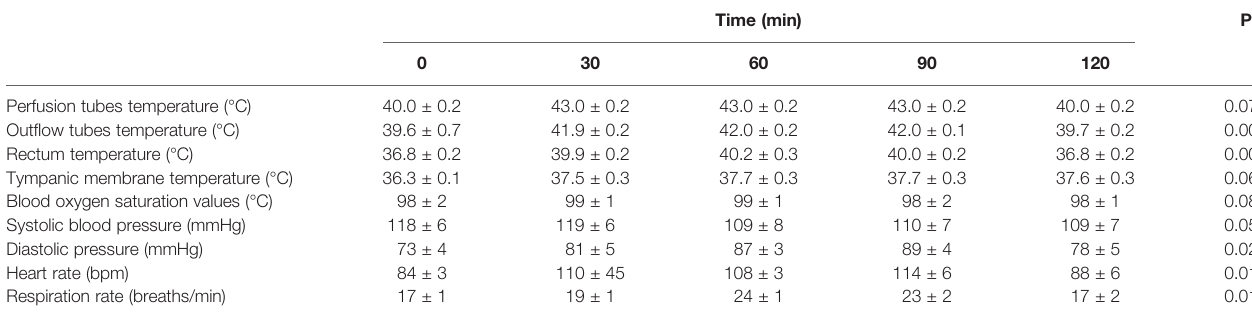
TABLE 2 | Effect of HIPEC on vital signs using the BR-TRG-I-type intraperitoneal